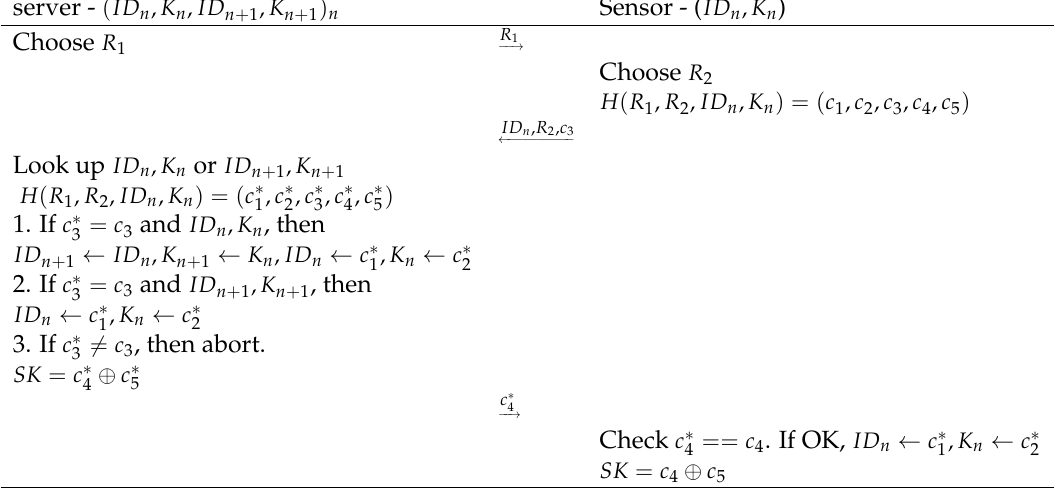
Figure 2. Steps and computations in the proposed authentication and key agreement scheme with storage.